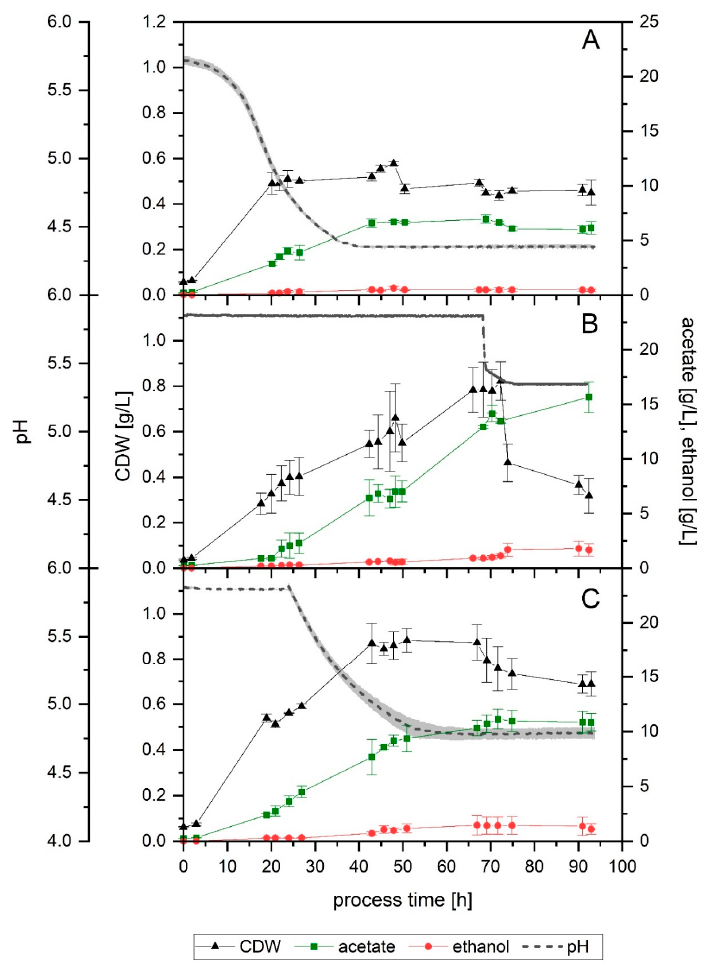
Figure 3. Growth, pH profile and product formation of: Setup 2 without pH regulation ( A ); Setup 3b with increased cysteine and pH change to 5.4 after 68 h ( B ); and Setup 5 with pH allowed to drop to 4.8 after 24 h ( C ). Average values of the triplicates ( n = 3) with STD for cell dry weight (CDW, black triangles), acetate (green squares), ethanol (red dots) and pH (grey dotted line). In (B), after 68 h, only the two fermenters where the pH was changed are plotted. The lightly colored area around the pH average represents the standard deviation. For CDW, acetate and ethanol points indicate actual measurements, lines are only depicted for clarity purposes. pH was measured on-line.